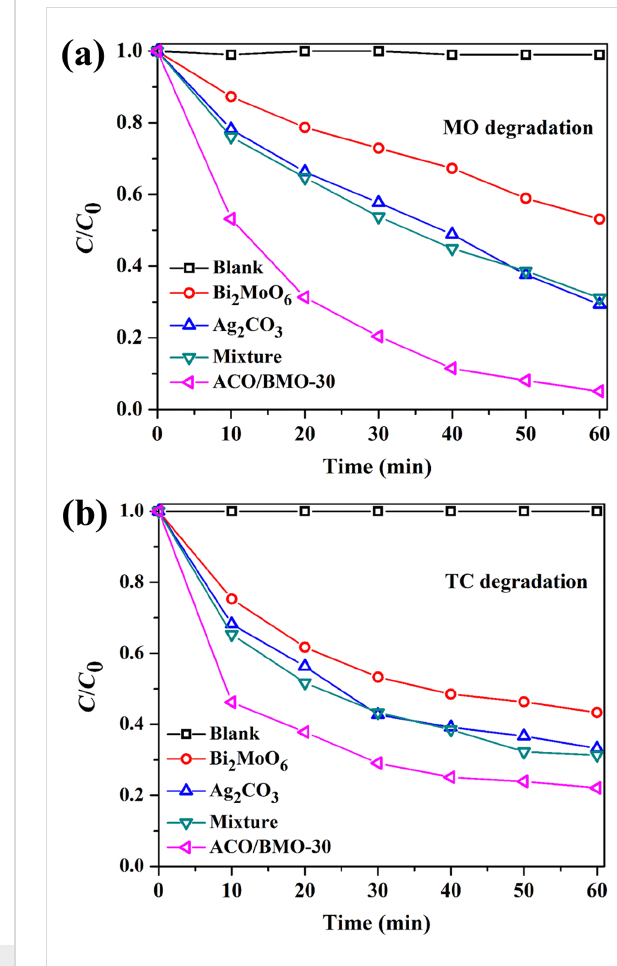
Figure 6: (a) Photocatalytic degradation of RhB over different sam- ples under visible light. (b) Rate constants of RhB degradation for dif- ferent catalysts.